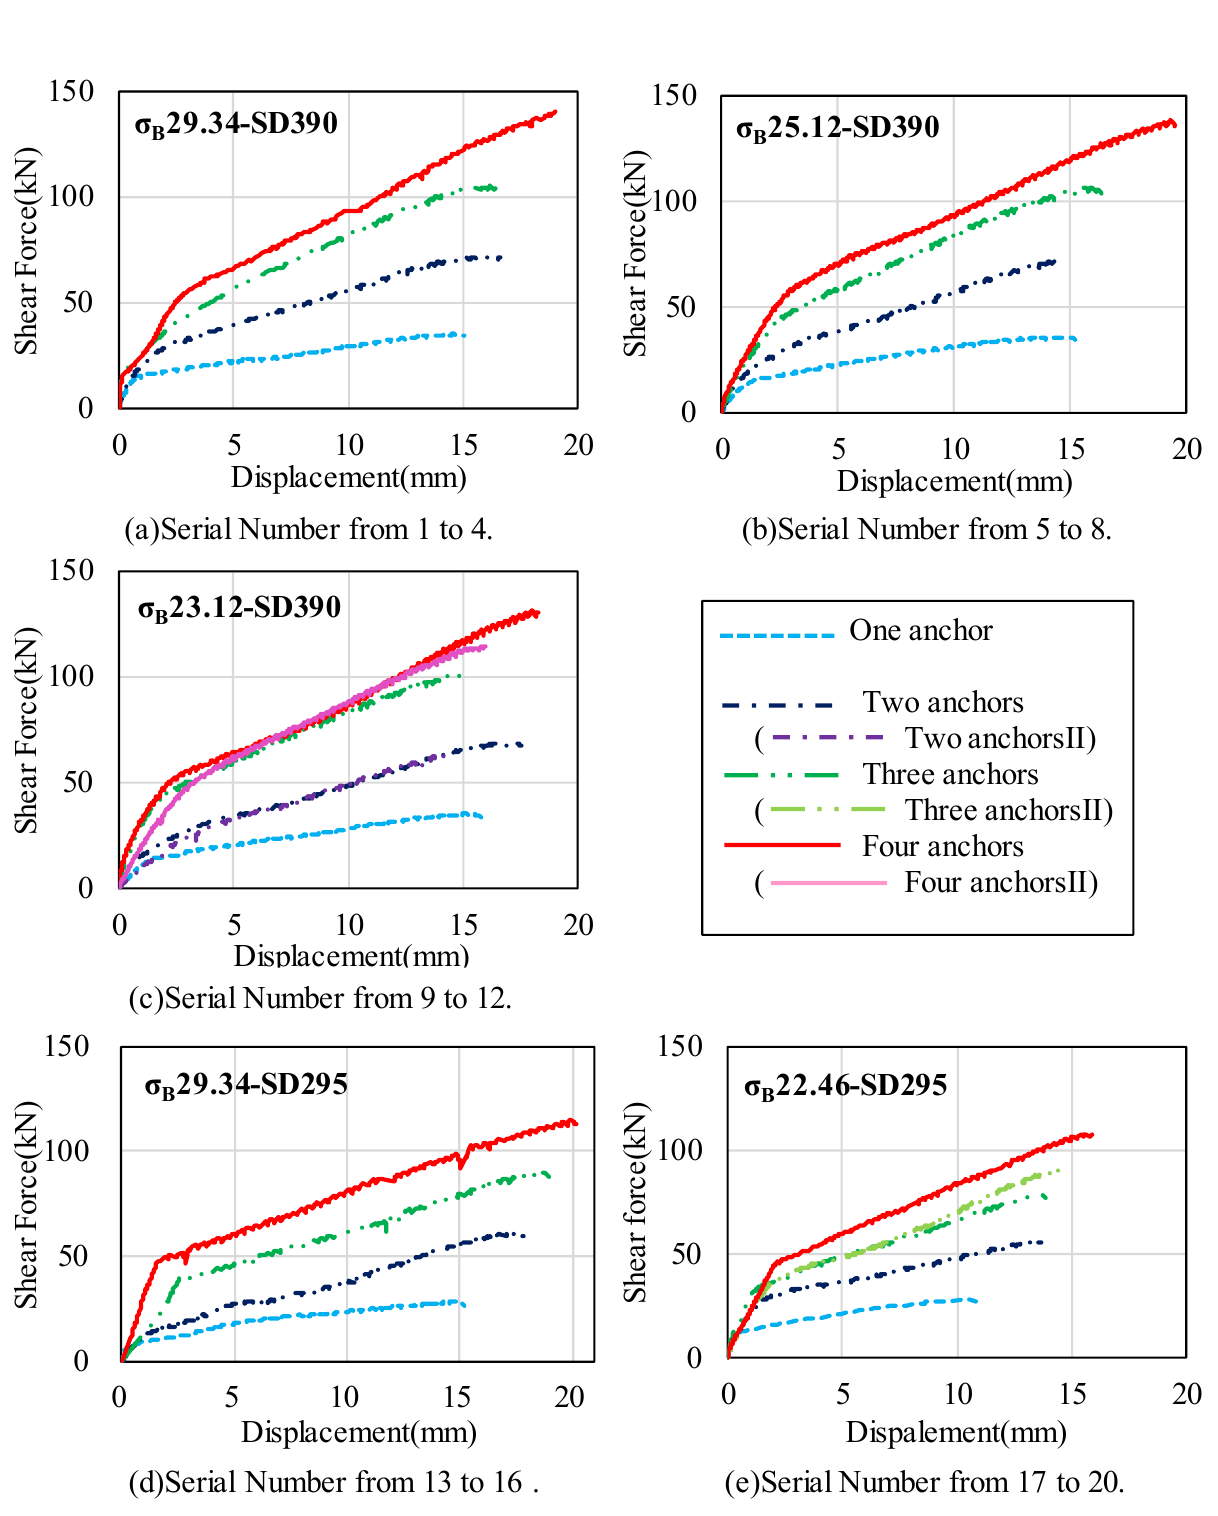
Figure 2. Shear Force - Shear Displacement